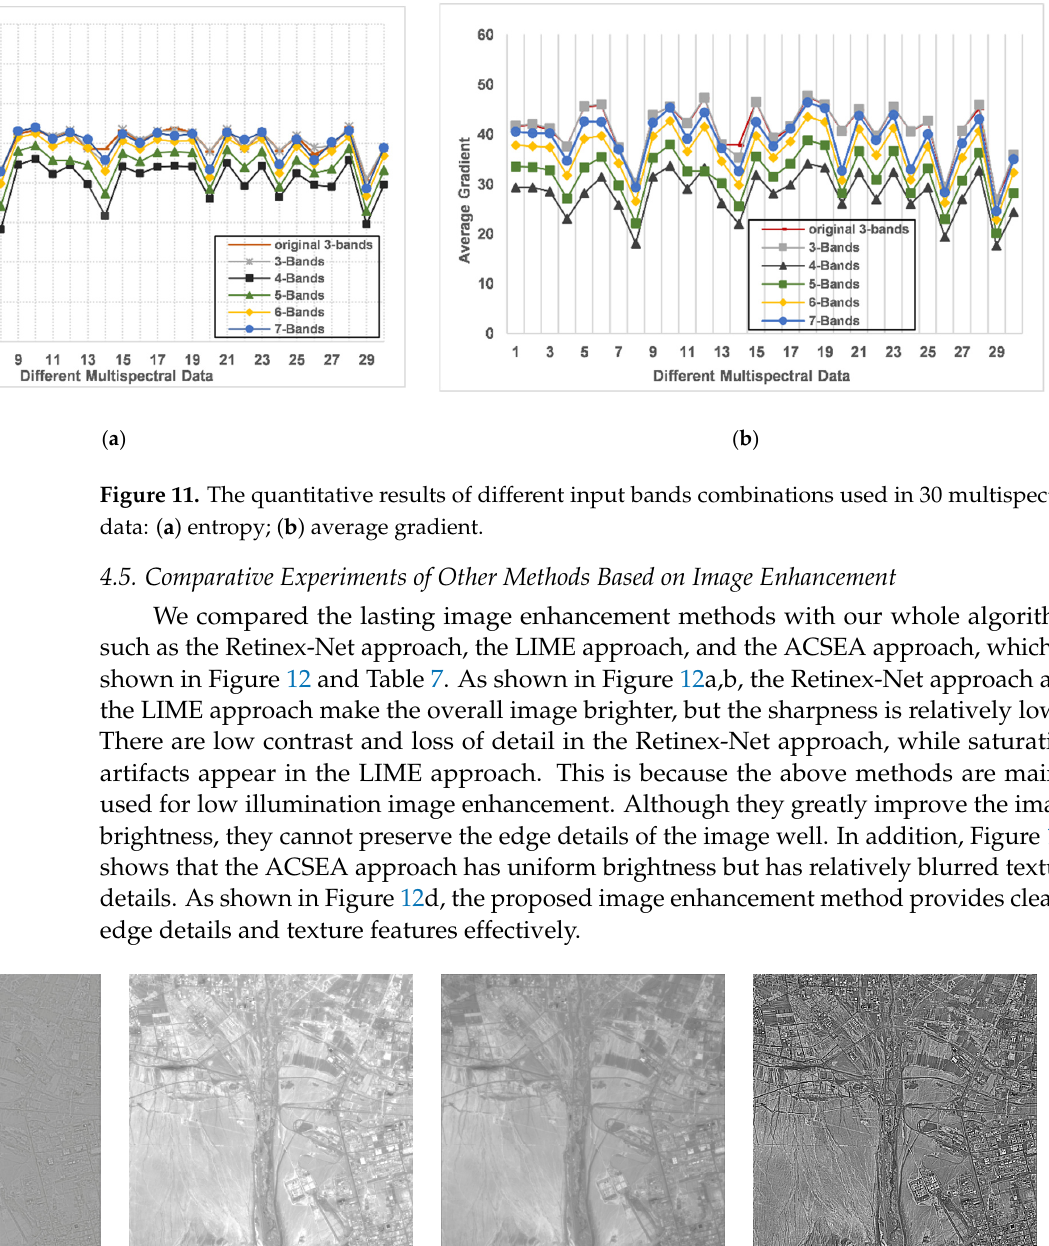
Figure 10. The histograms corresponding to enhanced data 1 by using different input bands combi- nations: ( a ) original DCP of 3-Bands; ( b ) IDCP of 3-Bands; ( c ) IDCP of 4-Bands; ( d ) IDCP of 5-Bands;